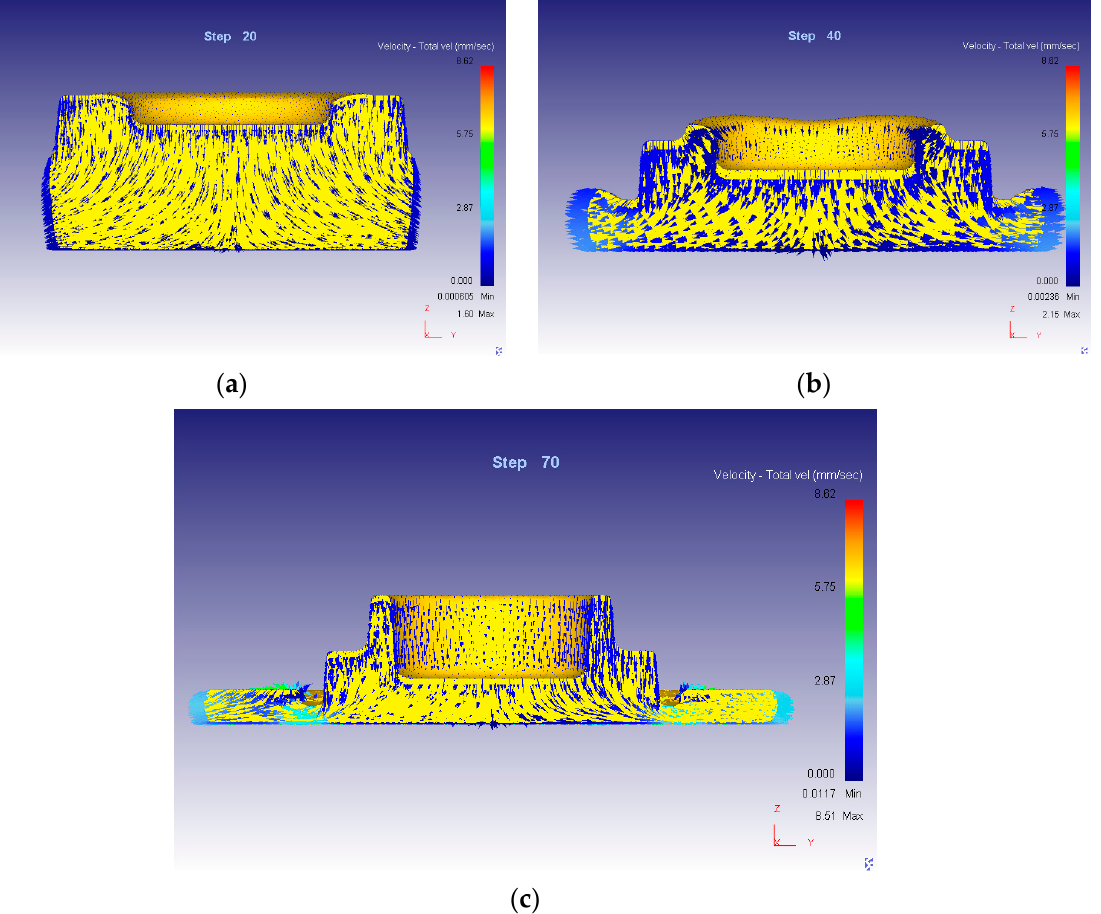
Figure 1. Schemes of the deformed state of the workpiece material: beginning of the process ( a ), intermediate state ( b ), end of the process ( c ).